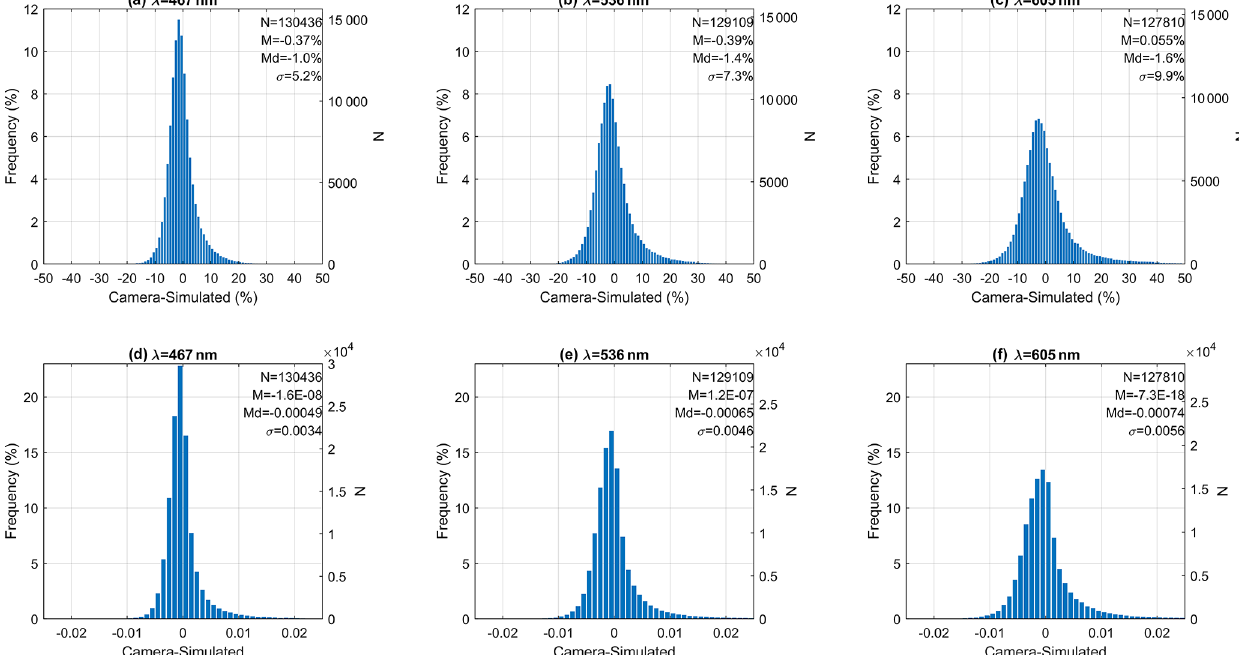
Figure 13. Frequency histograms of the relative (a–c) and absolute (d–f) differences between the camera and simulated normalized sky radiances for 467nm (a, d) , 536nm (b, e) and 605nm (c, f) . Radiances with scattering angles below 10 ◦ are not considered. The amount of data ( N ), the mean ( M ), median (Md) and standard deviation ( σ ) of the differences are also